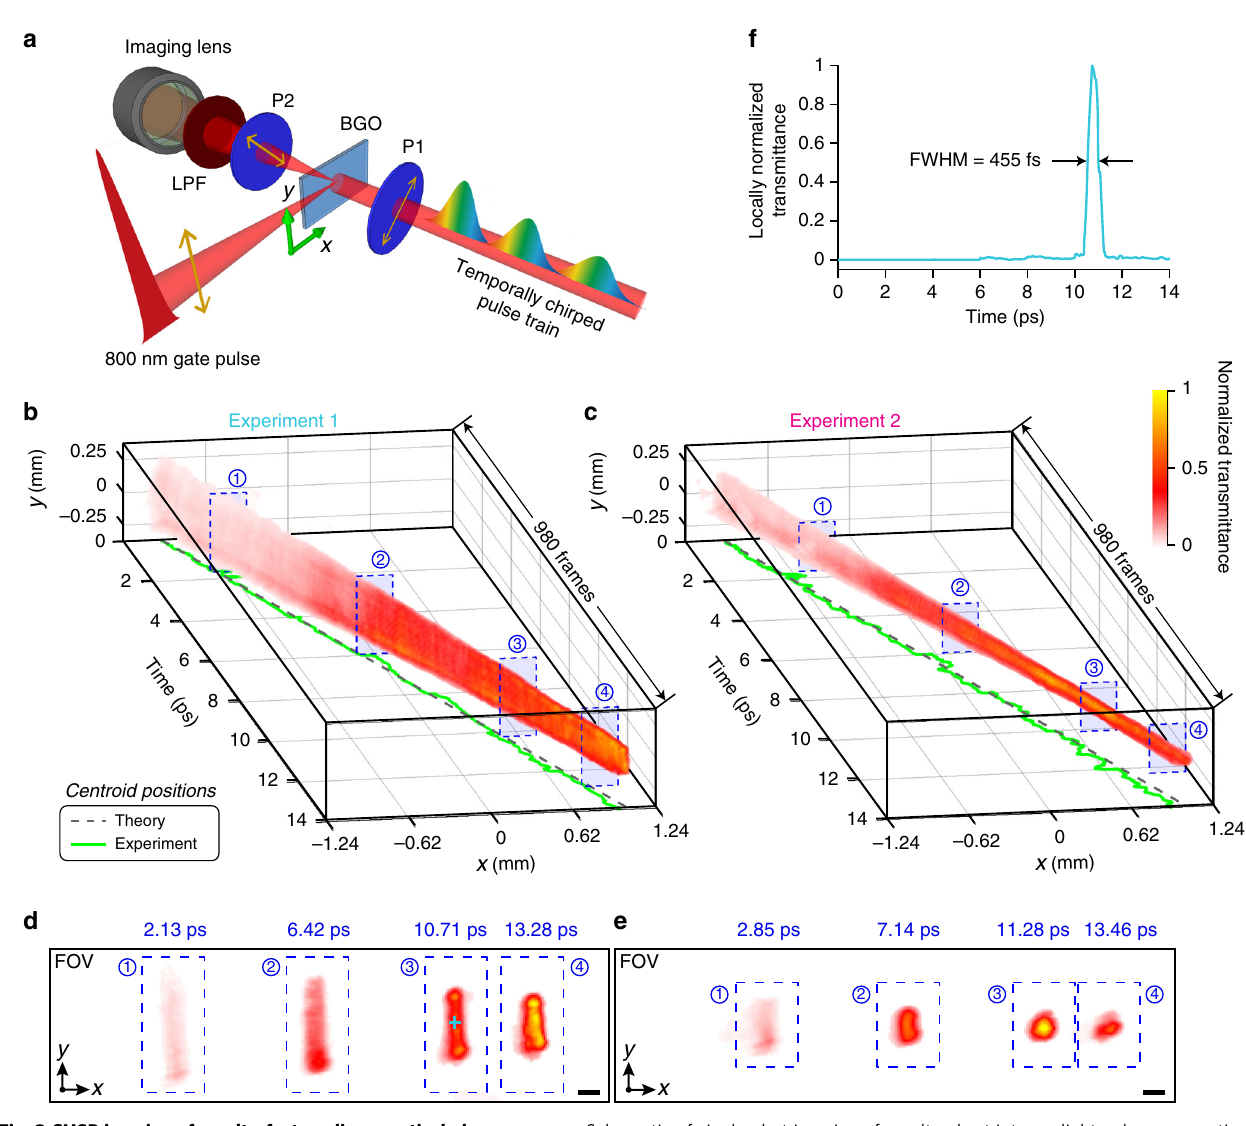
Fig. 3 CUSP imaging of an ultrafast nonlinear optical phenomenon. a Schematic of single-shot imaging of an ultrashort intense light pulse propagating in a Kerr medium (BGO). Polarizers P1 and P2 have polarization axes aligned at + 45° and – 45°, respectively. A long-pass fi lter, LPF, is used to block multi- photon fl uorescence. A complete schematic is in Supplementary Fig. 10. b , c 3D visualizations of the reconstructed 980-frame movies acquired at 70 Tfps when the gate focus is ( b ) outside and ( c ) inside the fi eld of view (FOV). Transmittance is normalized to each maximum. See the full movies in Supplementary Movie 2. The bottom surfaces plot the centroid x positions of the reconstructed gate pulse versus time and the corresponding theoretical calculations. d , e Representative snapshots of the normalized transmittance pro fi les (i.e. beam pro fi les of the gate pulse) in the x – y plane for d Experiment 1 and e Experiment 2, at selected time frames de fi ned by blue dashed boxes in ( b ) and ( c ), respectively. Scale bars: 0.1 mm. f Evolution of the locally normalized light transmittance at a selected spatial point in Experiment 1 [cyan cross in ( d